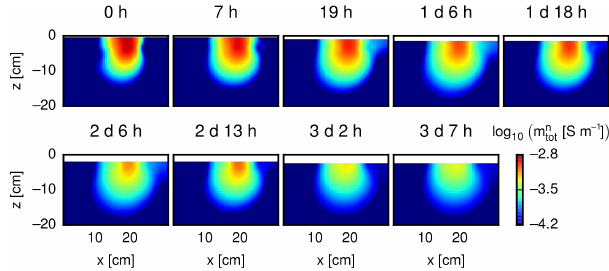
Figure 9. Spatial distribution of DD-derived parameter m n tot for se- lected time steps. The top boundary is adjusted according to the estimated water table for each measurement time.